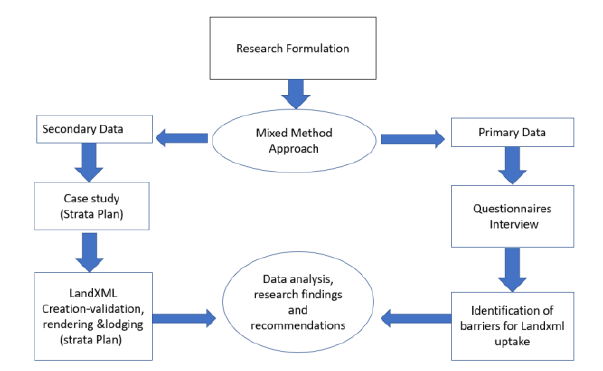
Figure 3: Research Framework